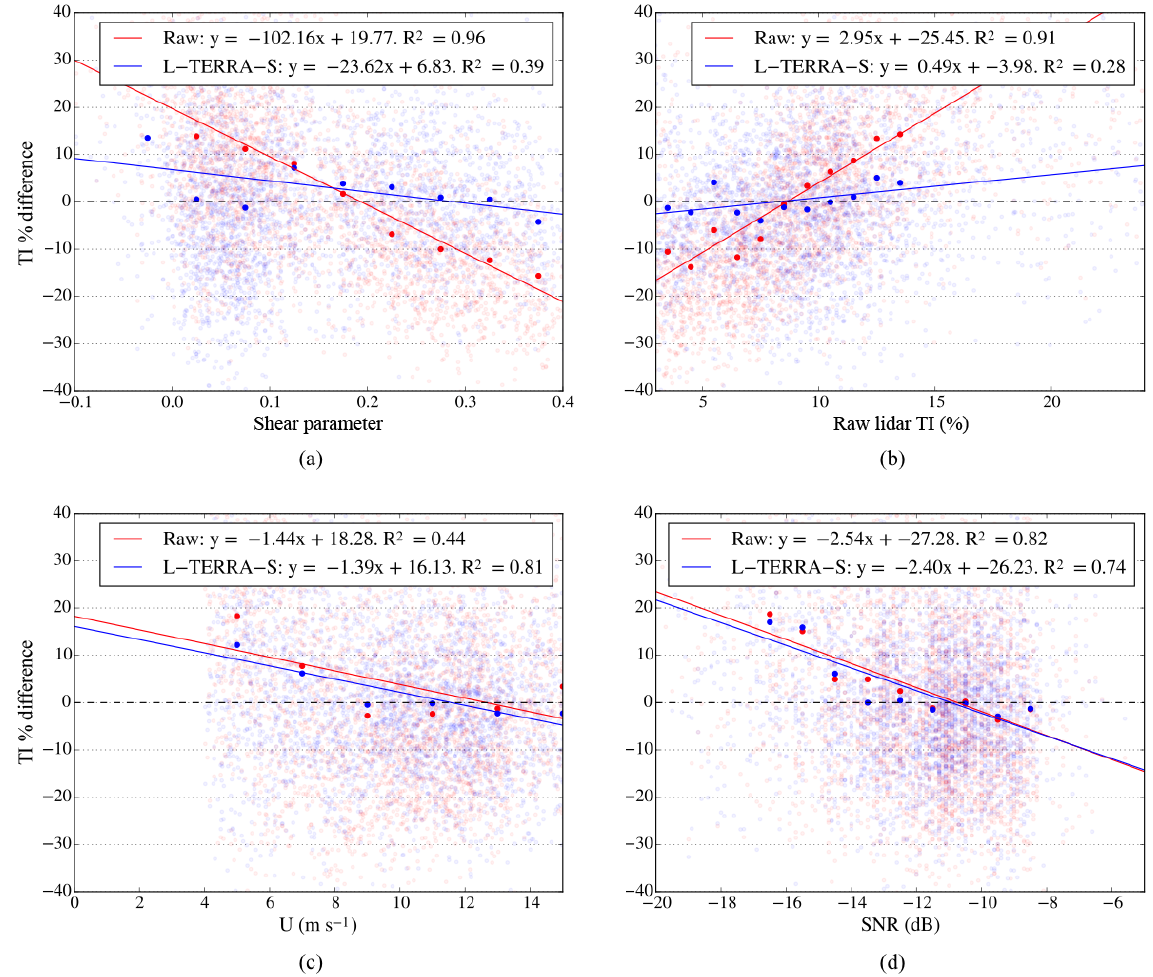
Figure 6. Percent difference between WC and sonic TI for the ARM site as a function of (a) shear parameter, (b) raw WC TI, (c) mean wind speed, and (d) SNR. Differences are shown both before (red circles) and after (blue circles) L-TERRA-S has been applied. Solid circles correspond to averages of binned data and solid lines correspond to regression line fits to bin means, following the procedure in Annex L of IEC 61400-12-1, Draft Edition (International Electrotechnical Commission,